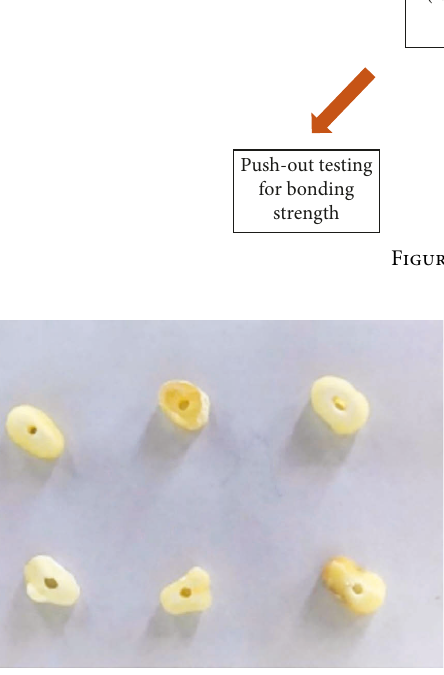
Figure 2: Specimens prepared for the study (lumen size